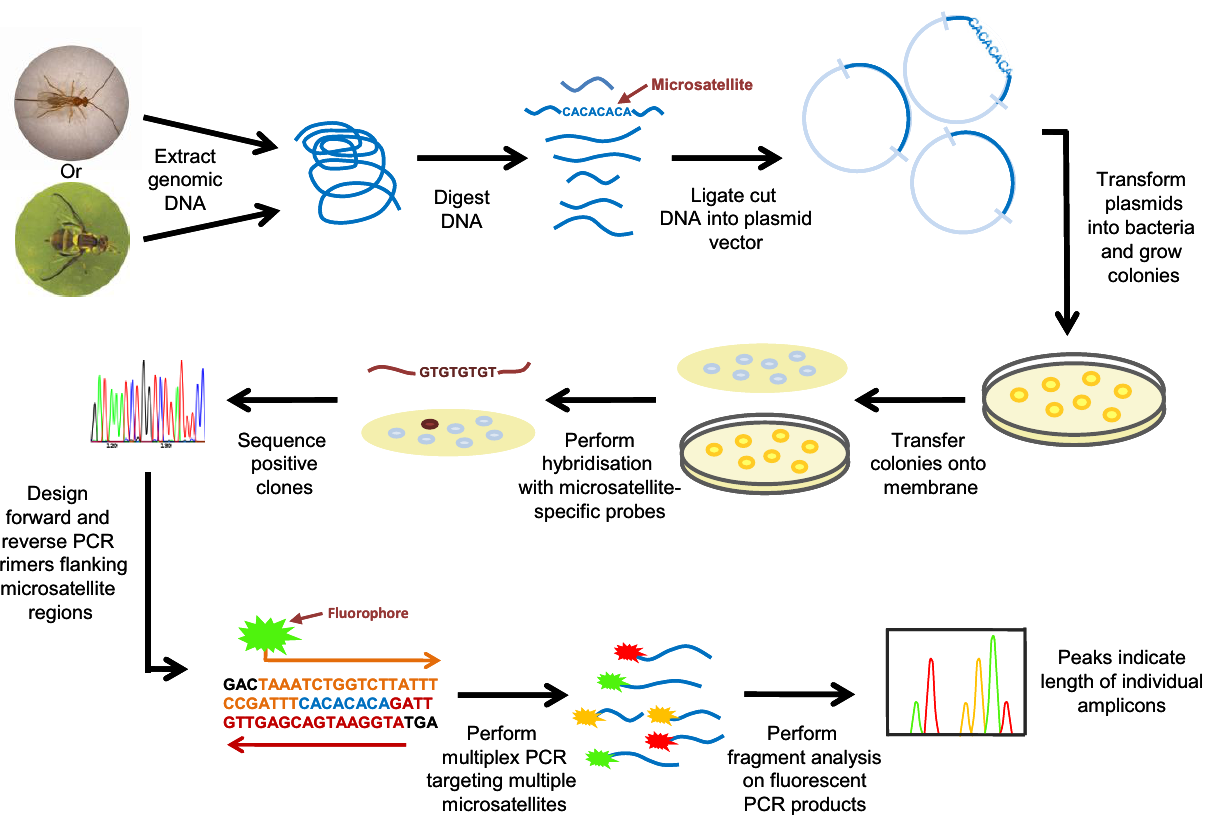
Figure 1. Development and use of microsatellite markers for species